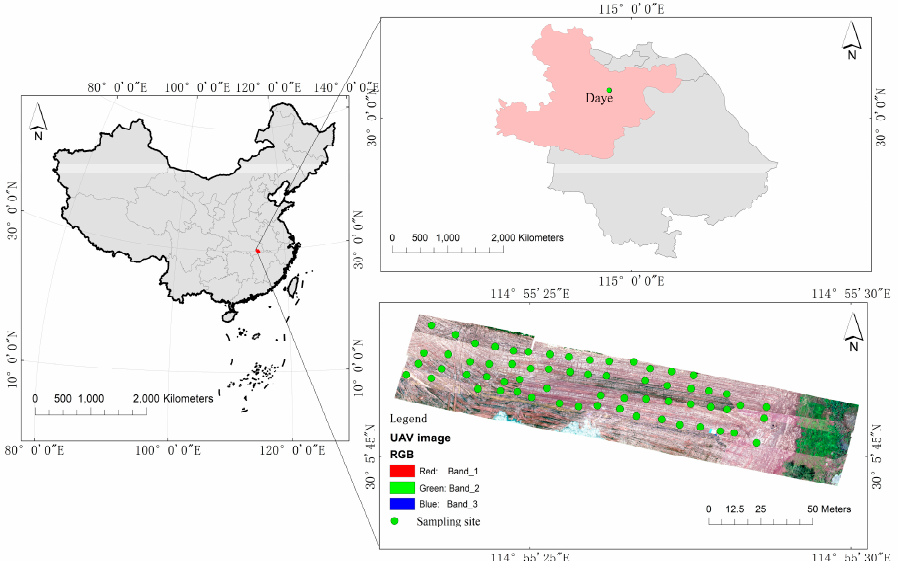
Figure 1. The location of the study area and the locations of the sampling (the unmanned aerial vehicle (UAV) image was taken by a DJI Matrice 600 Pro